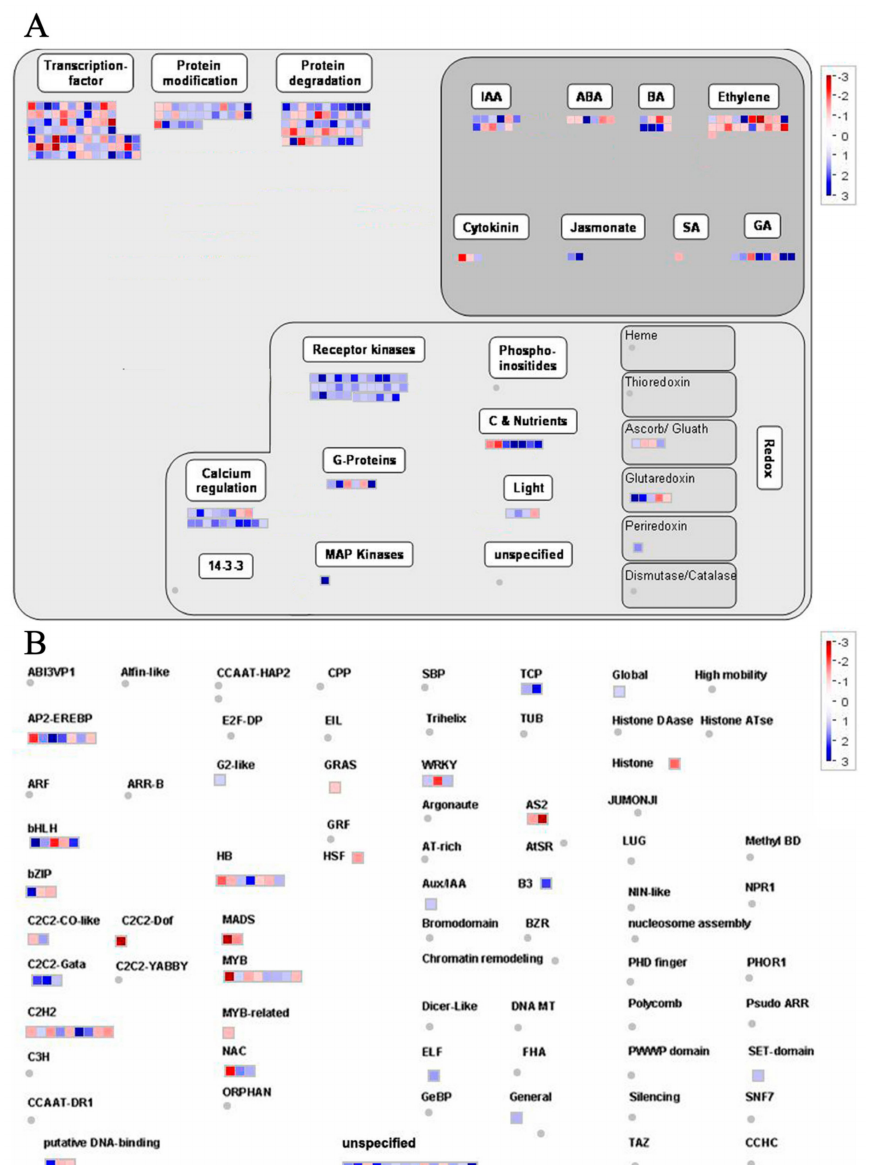
Figure 7. Overview of gene expression and transcription responses visualized using Mapman software in RH vs. RC. ( A ) Overview of regulation enrichment among DEGs in comparing RH and RC under weak light. ( B ) Main transcription factor (TF) family enrichment pathway among DEGs. The transcriptional changes in weak light and exogenous Ca 2 + . Genes in blue and red indicate up-regulation and down-regulation in RH and RC samples relative to DEGs. Individual genes are represented by small squares. The scale bar displays transformed log 2 fold